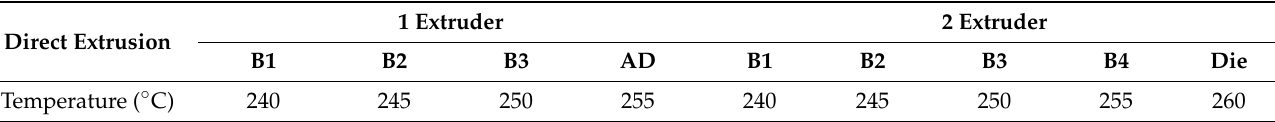
Table 3. Extruder temperature profile for the LFT direct extrusion manufacturing processes.